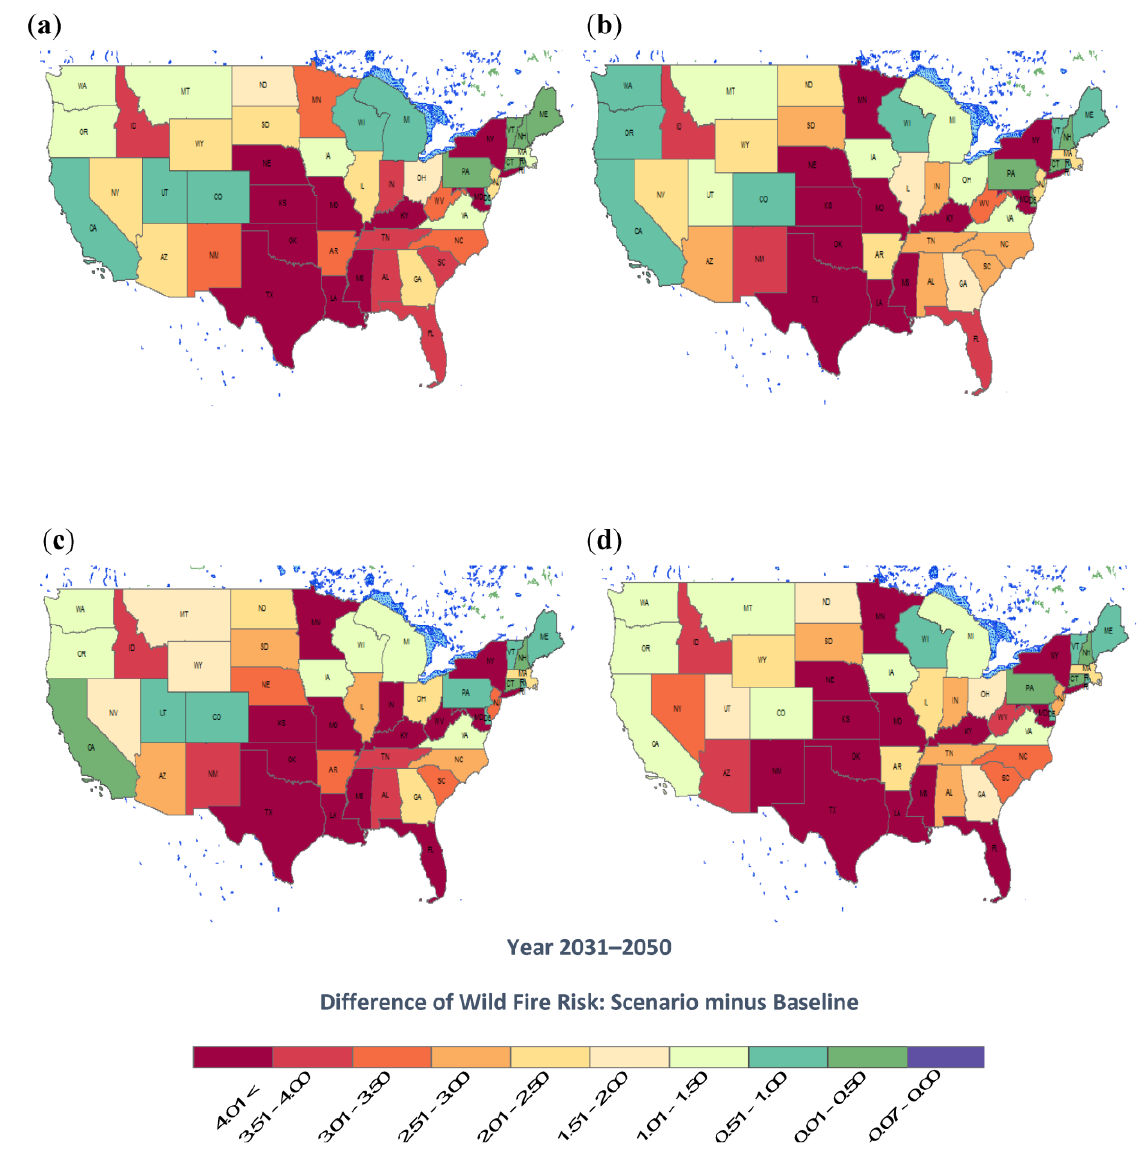
Figure 3. ( a ) Change in wildfire risk relative to the baseline (historical average) with the future climate projected by the HadCM3 model under the RCP 4.5 scenario; ( b ) Change in wildfire risk relative to the baseline with the future climate projected by the NOAA-GFDL model under the RCP 4.5 scenario; ( c ) Change in wildfire risk relative to the baseline with the future climate projected by the HadCM3 model under the RCP 8.5 scenario; ( d ) Change in wildfire risk relative to the baseline with the future climate projected by the NOAA-GFDL model under the RCP 8.5 scenario. The changes in wildfire risk are calculated by subtracting the historical average wildfire risk from the projected future wildfire risk based on the climatic conditions projected by the GCMs. This figure indicates the long-run (2031–2050) impact of climate change on wildfire